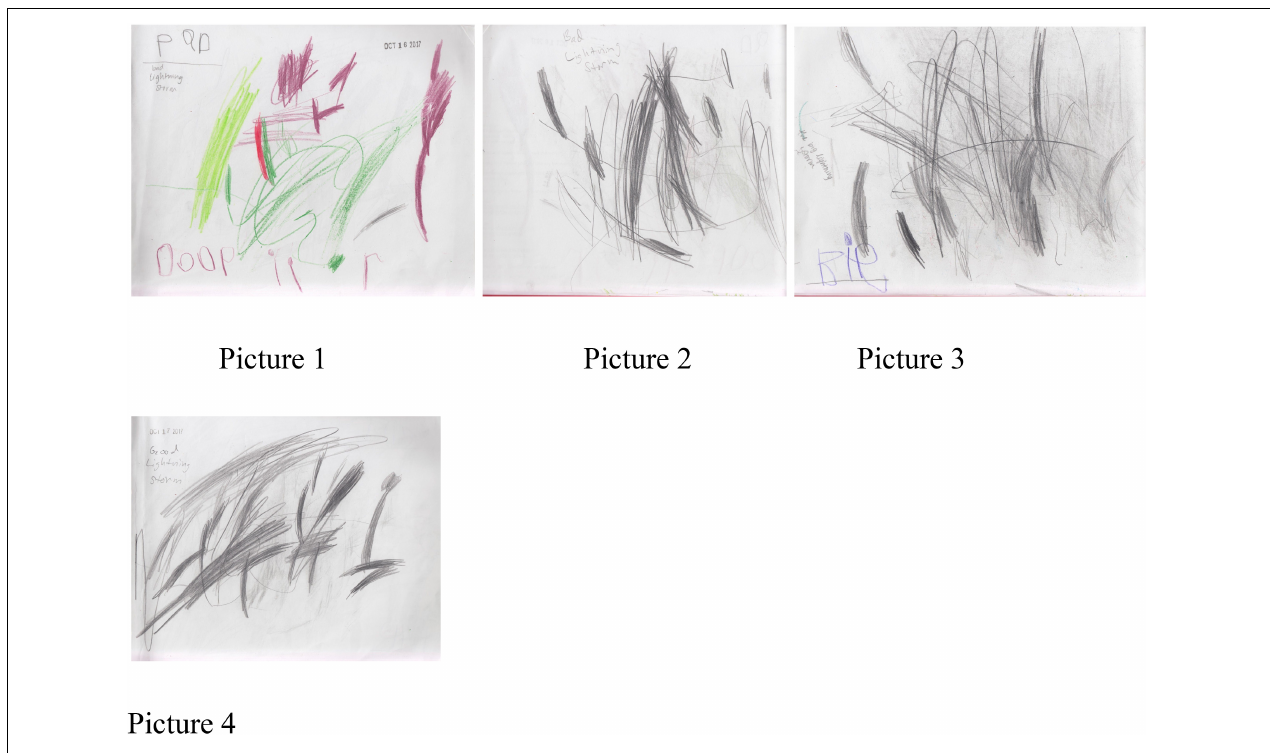
FIGURE 1 | Pictures 1–4 detailing a story from Lewis, a 4-year-old student.